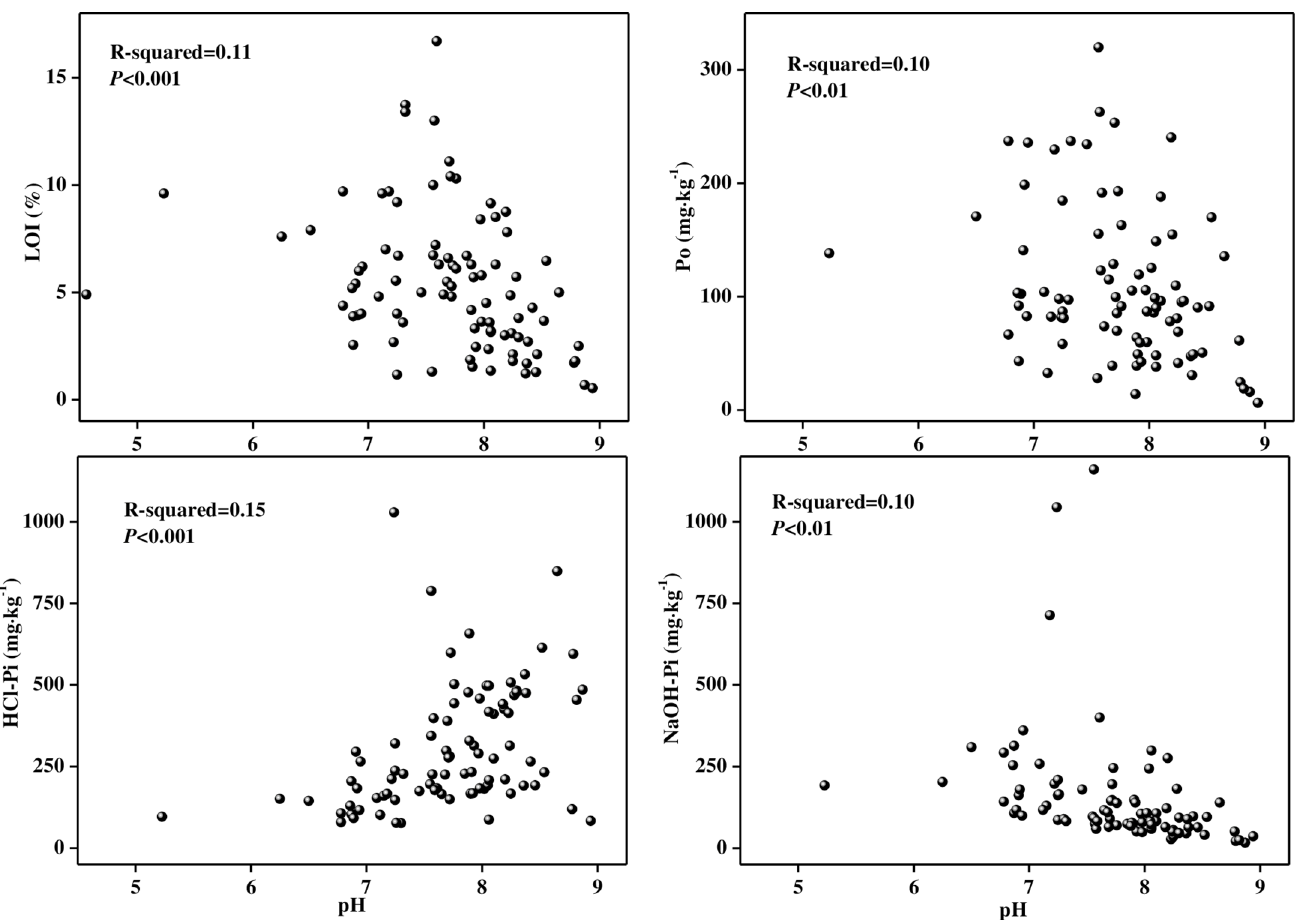
Fig 4. Relationships between pH and NaOH-Pi, HCl-Pi, LOI and Po in sediments of Eastern China. NaOH-Pi, LOI and MUP were negatively correlated with pH ( p < 0.01, n = 89); HCl-Pi was positively correlated with pH ( p < 0.01, n = 89).